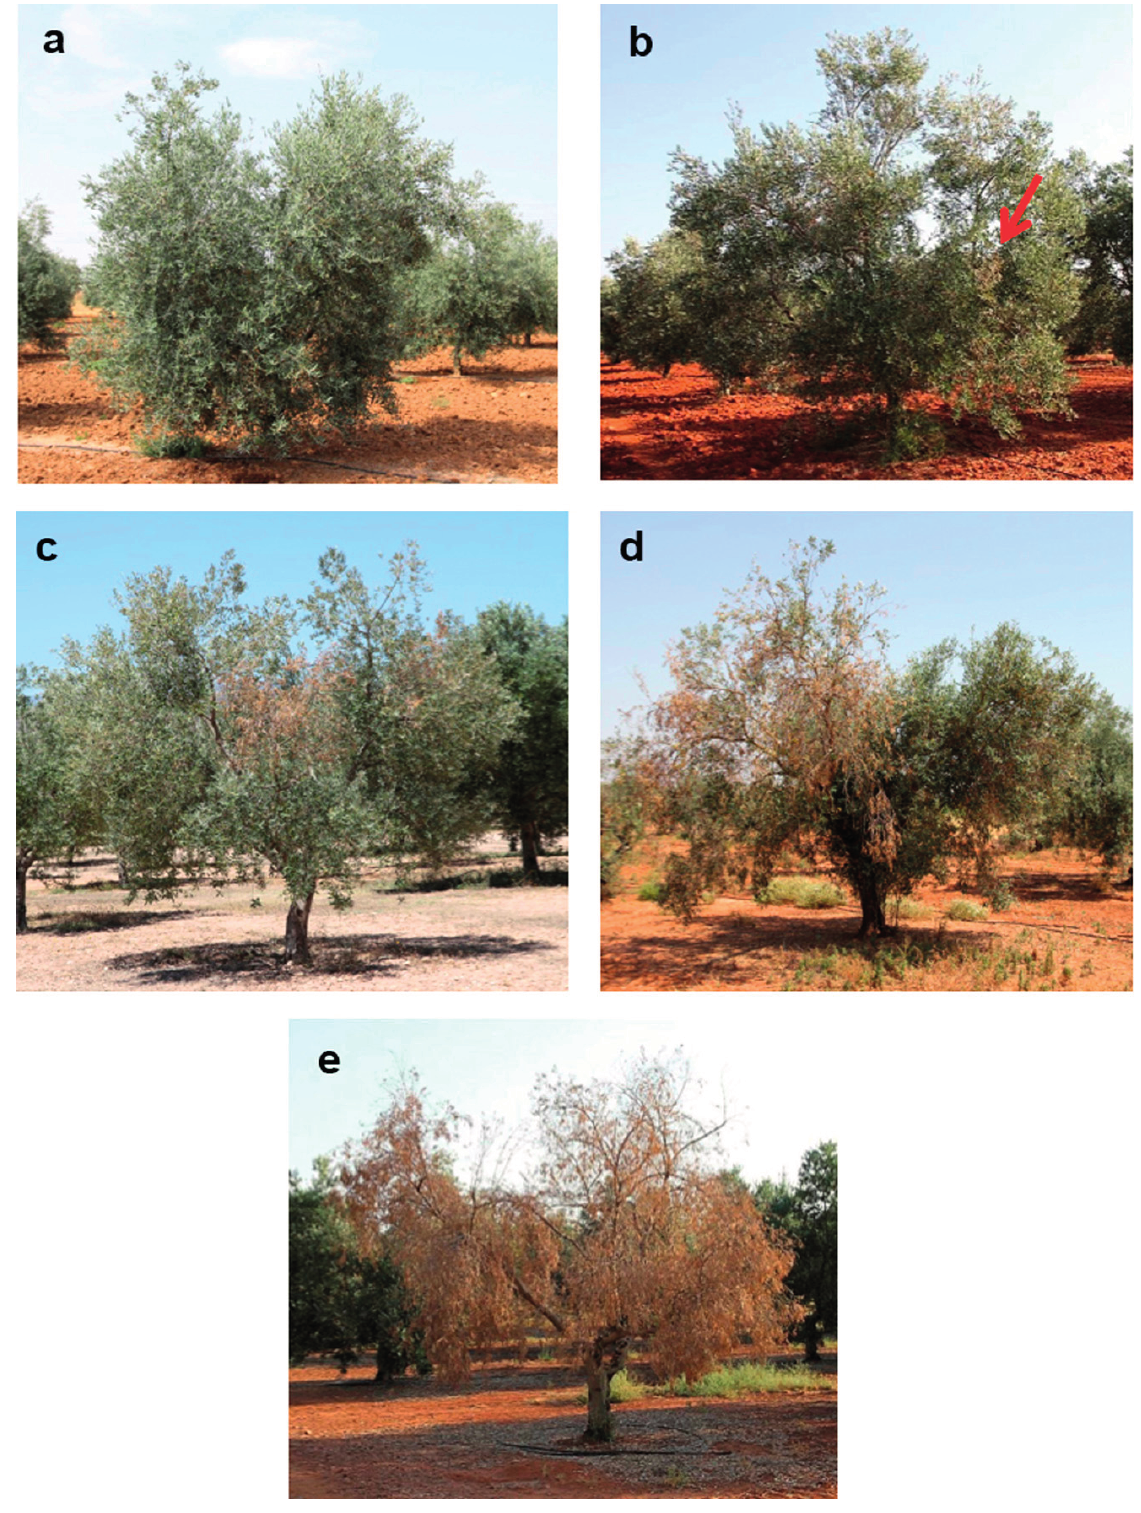
Figure 2. RGB images showing olive trees with the five different Verticillium wilt severity classes: ( a ) asymptomatic, ( b ) initial, ( c ) low, ( d ) moderate and ( e ) severe disease